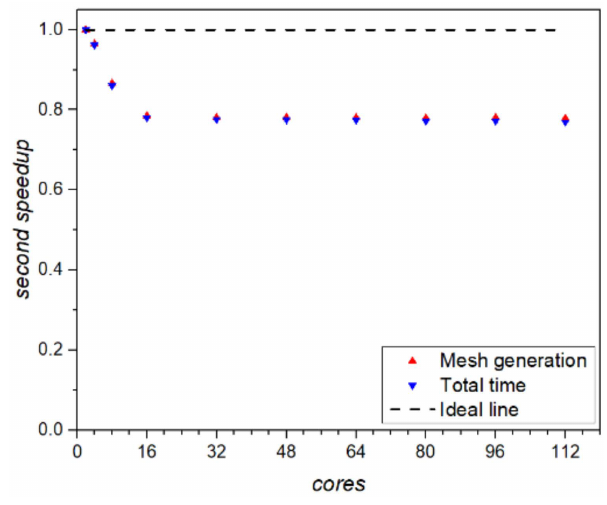
Figure 11. The second